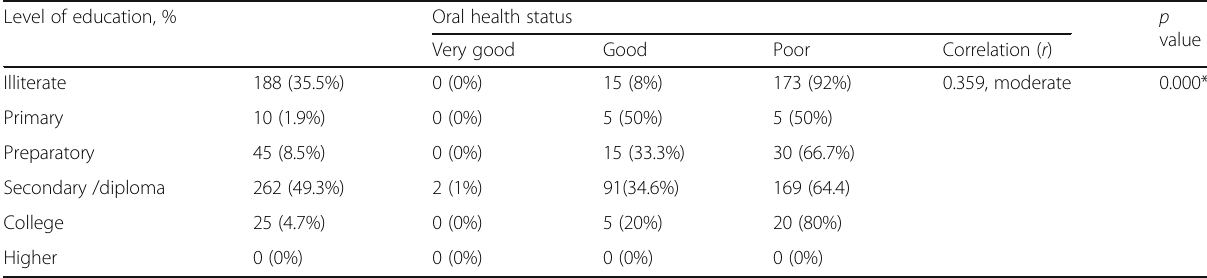
Table 3 Oral health status among different educational levels Level of education,